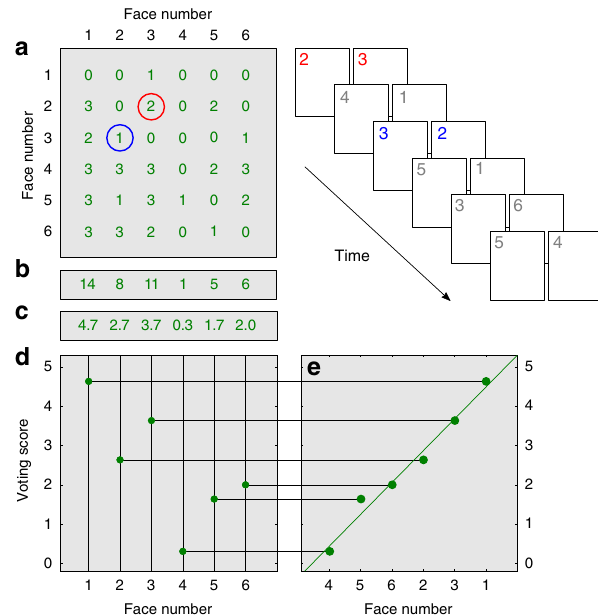
Fig. 2 Method of paired comparisons applied to eyewitness identi fi cation. Subjects were presented with a sequence of face pairs shown schematically at top right (here using six numerals). The task was to indicate which face in each pair was more similar to the remembered face of the perpetrator. a Outcomes of pairwise comparisons were recorded in a voting matrix. The matrix displayed contains results of 45 paired comparisons (15 pairs each presented three times) for one subject, S15. b The sum of votes in each column is the cumulative vote for every face. c Dividing the cumulative vote of every face by the number of face repetitions in the lineup yields the normalized voting score for every face ( c ). Voting scores range from zero (face was never selected) to fi ve (face was selected every time it was presented). d , e Voting scores are plotted as a function of ordinal face number in ( d ), and as a function of face number ranked by the voting score in ( e ). The latter plot is the voting function, whose slope re fl ects consistency of